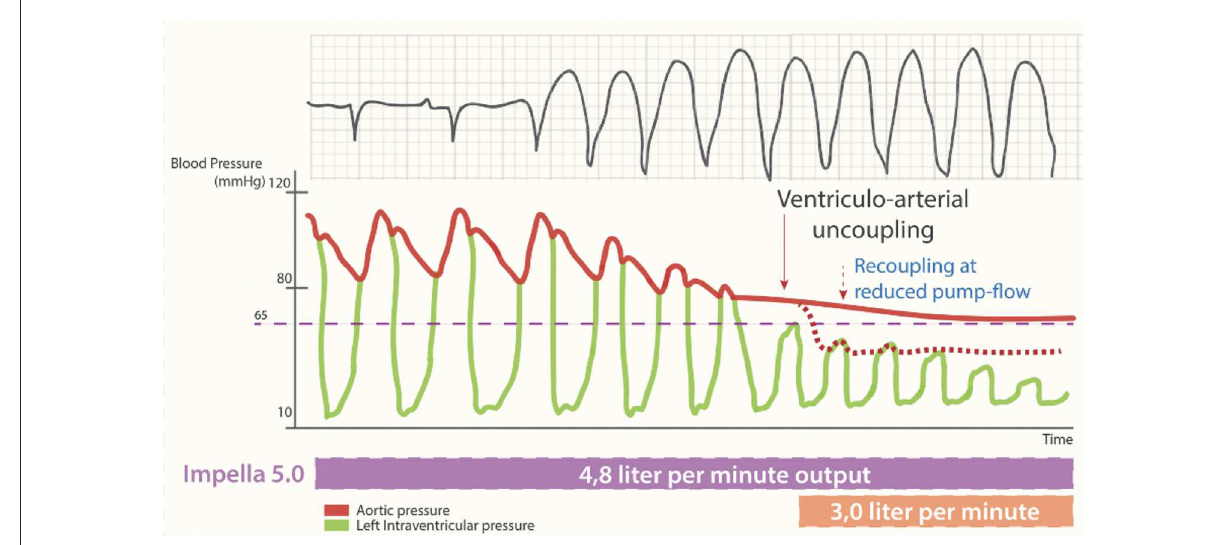
FIGURE3 Cardiac output during percutaneous MCS supported sustained ventricular tachycardia. Loss of pulse pressure and cardiac output during the arrhythmogenic storm phase. Ventriculo-arterial uncoupling with sustained output, generated by non-pulsatile output (4.8 L/min) by the Impella-5.0 support and resulting in a systemic blood pressure of 65 mmHg [reproduced with permission from (27)].